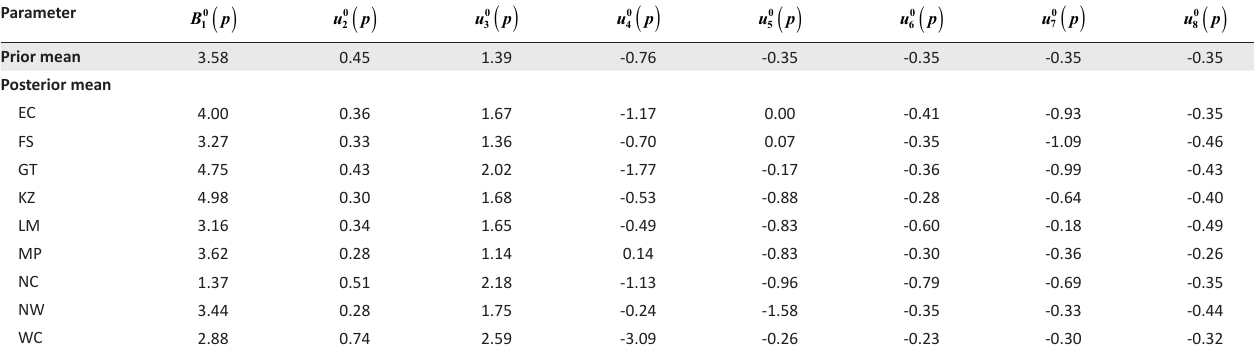
TABLE 2: Prior and posterior means for Step 3 (children only).